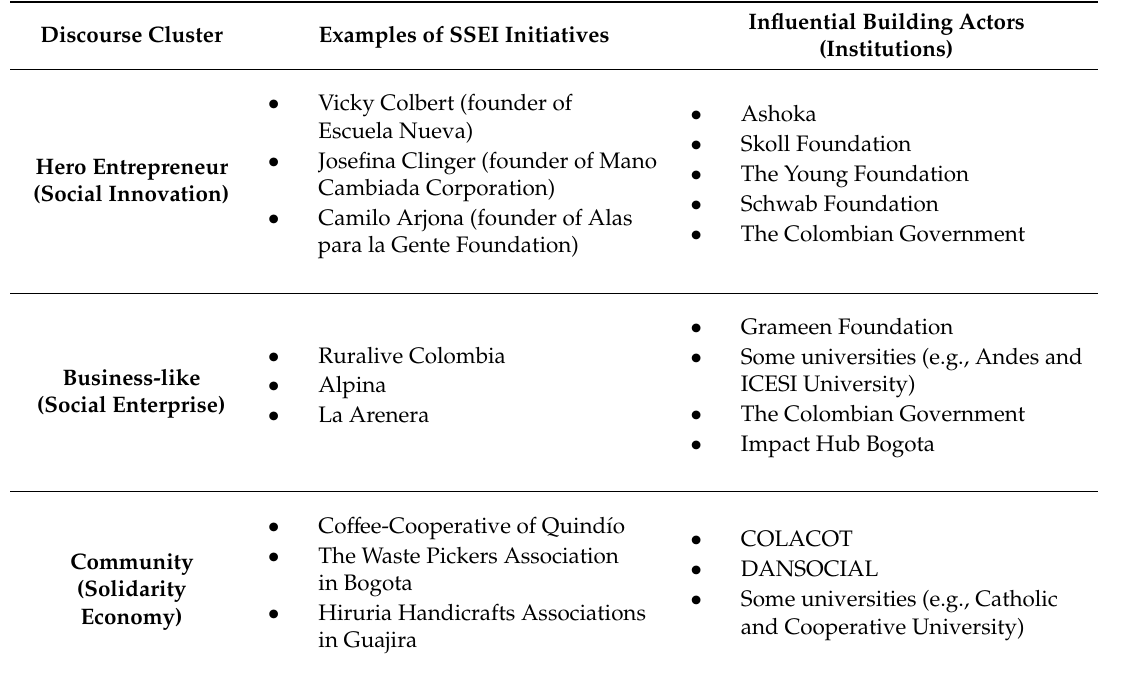
Table 5. Solidarity economy, social enterprise, and innovation discourses in Colombia. COLACOT: Latin America Confederation of Workers